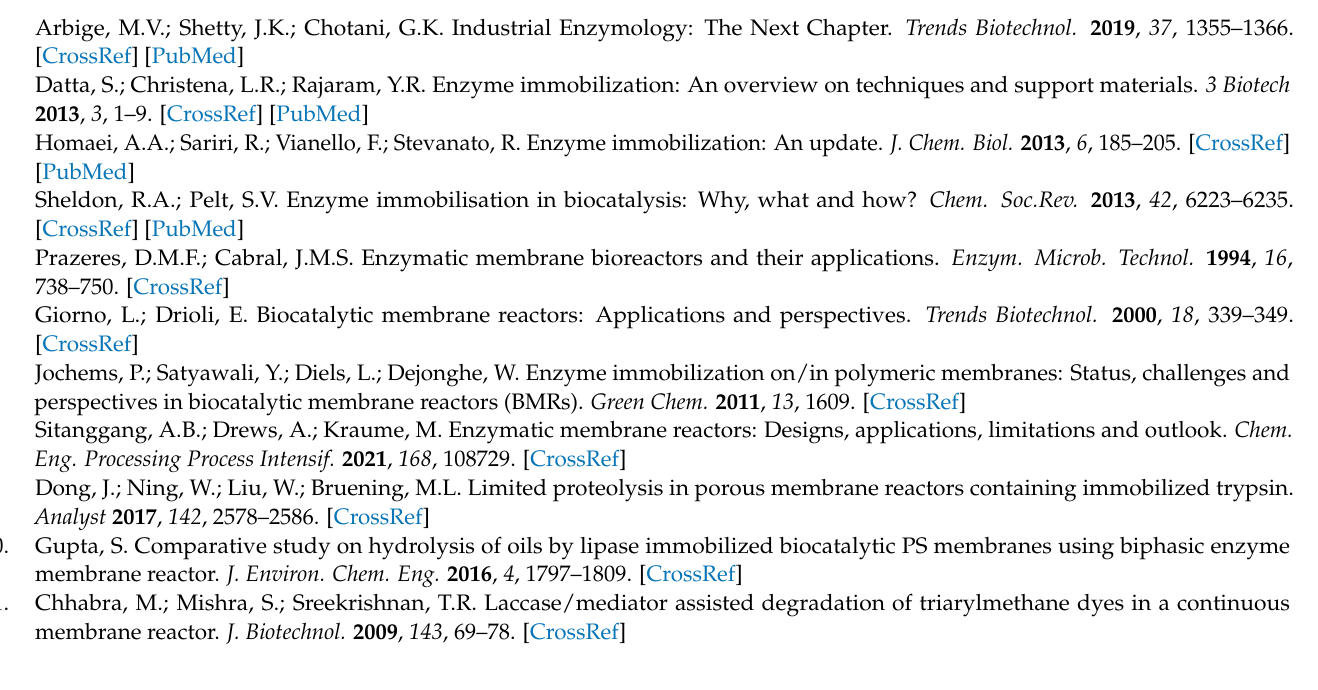
assay; Figure S2: DynaFit script; Figure S3: Boxplots of reaction rates; Figure S4: Diagnostics of RSM design; Table S1: Data of RSM design; Table S2: XPS data of fouled